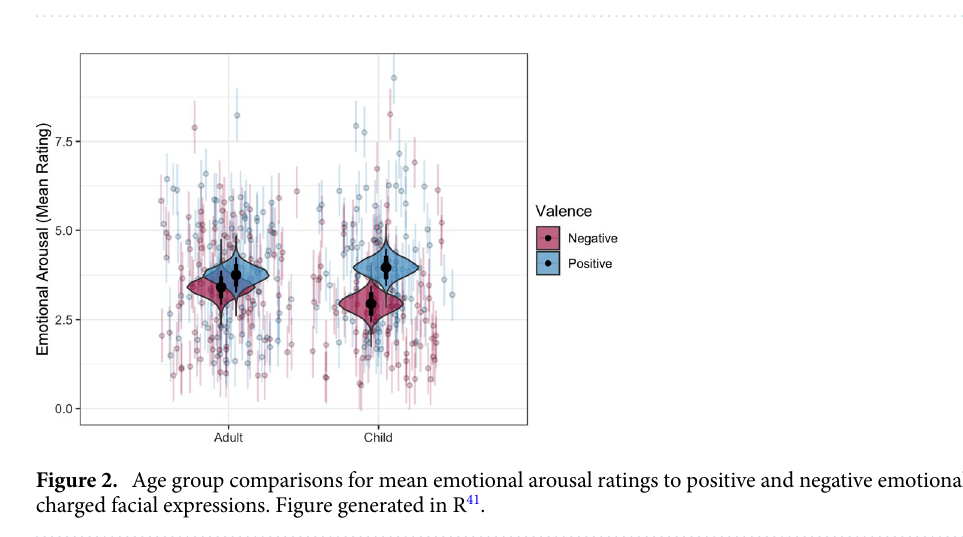
Figure 1. Group comparisons for ( a ) mean accuracy in emotion recognition for cognitive empathy surveys, and ( b ) mean resonance rating for emotional empathy surveys. Figure generated in R 41 .